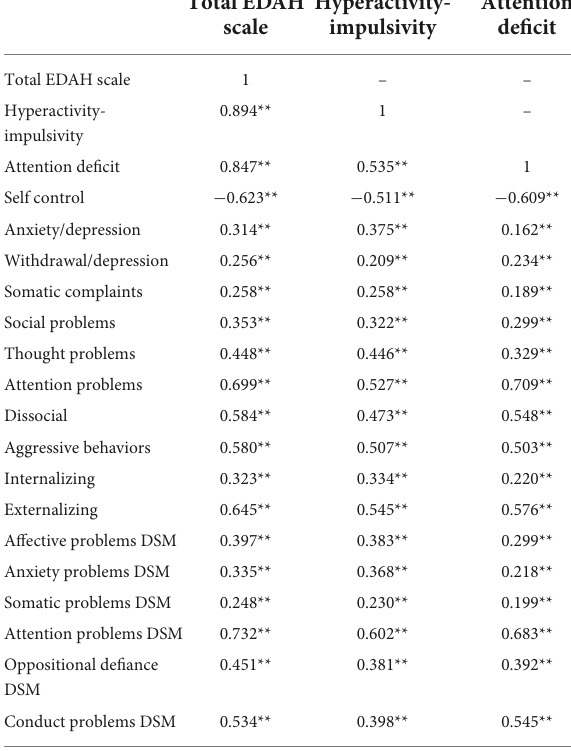
TABLE 5 Correlations between EDAH scales adapted with the self-control questionnaire and youth self-report (YSR)